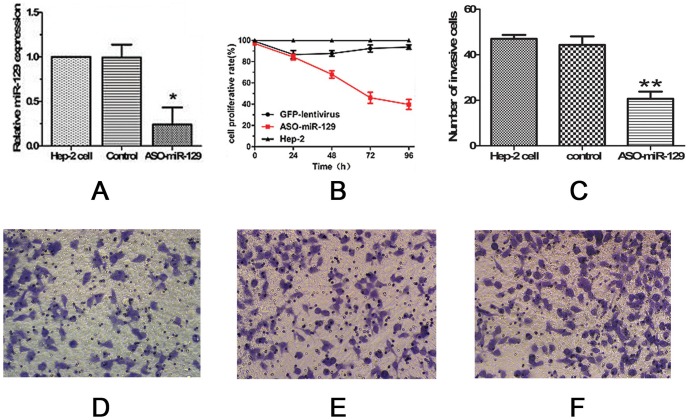
ASO-miR-129-5p down-regulates miR-129-5p and reduces proliferation and migration of Hep-2 cells. (A) miR-129-5p expression was significantly decreased after ASO-miR-129-5p transfection compared to GFP transfection (control) or untreated Hep-2 cells (Hep-2 cell) measured by real-time RT-PCR. (* P<0.05). (B) Less proliferation was measured in the ASO-miR-129-5p group compared to control groups at 48, 72, and 96 h post-transfection (P<0.05). (C) Average number of Hep-2 cells in each group that migrated to the lower chambers of transwell plates in FOV (**P<0.01). (D) Representative images of migrating cells in the ASO-miR-129-5p group 72 h after transfection. (E) Representative images of migrating cells in the GFP group 72 h after transfection. (F): Representative images of migrating cells in the untreated group 72 h after transfection.